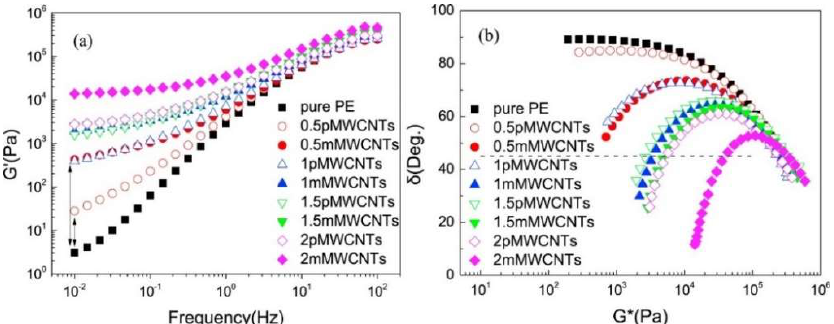
Figure 4. ( a ) Dynamic storage modulus (G′) and ( b ) v-GP plots for the composites with various unmodified (pMWCNTs) and functionalized (mMWCNTs) nanofiller loadings. Reprinted with permission from [66]. Copyright (2019) Elsevier.